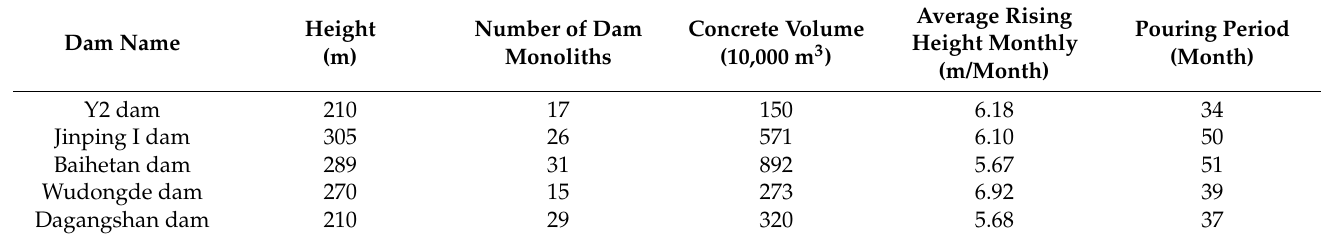
Table 12. The key construction parameters of arch dams in China.